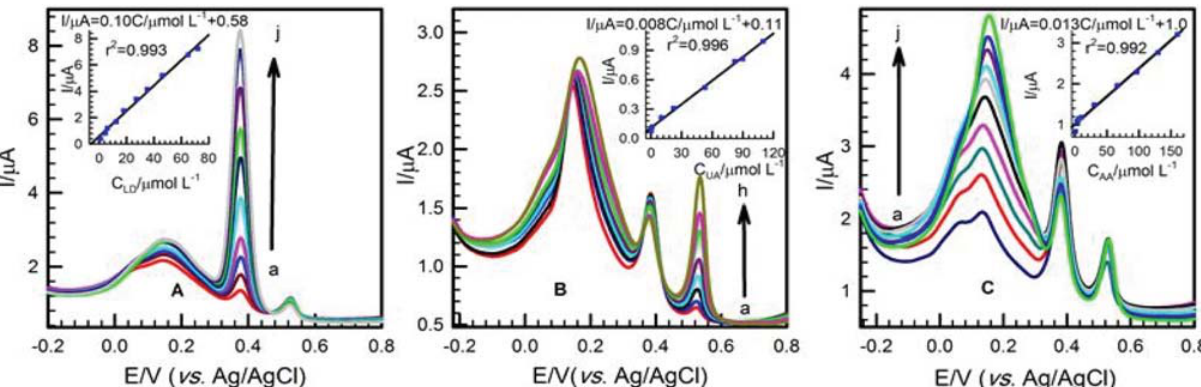
Figure 7. Differential pulse voltammograms of PDB/MWCNTs-GCE in PBS 0.11 mol L –1 (pH 3), containing (A) LD concentrations: (a) 0.8, (b) 4.5, (c) 6, (d) 12, (e) 18, (f) 27, (g) 35, (h) 46, (i) 65, (j) 72 μmol L –1 in the presence of 50 μmol L –1 UA and 200 μmol L –1 AA; (B) UA concentra- tions: (a) 0.3, (b) 1, (c) 10, (d) 22, (e) 53, (f) 82, (g) 90, (h) 110 μmol L –1 in the presence of 1.7 μmol L –1 LD and 220 μmol L –1 AA; (C) AA concen- trations: (a) 1, (b) 3, (c) 4.5, (d) 6, (e) 10, (f) 30, (g) 66, (h) 97, (i) 130, (j) 160 μmol L –1 in the presence of 2 μmol L –1 LD and 20 μmol L –1 UA. In- sets: The related calibration plots from the DPVs are shown in (A), (B) and